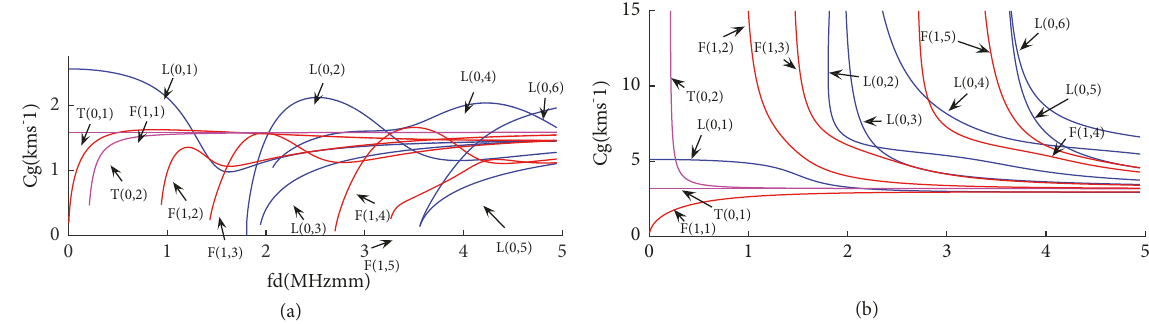
Figure 1: Dispersion curves of (a) phase velocity and (b) group velocity of a cylindrical shaft.